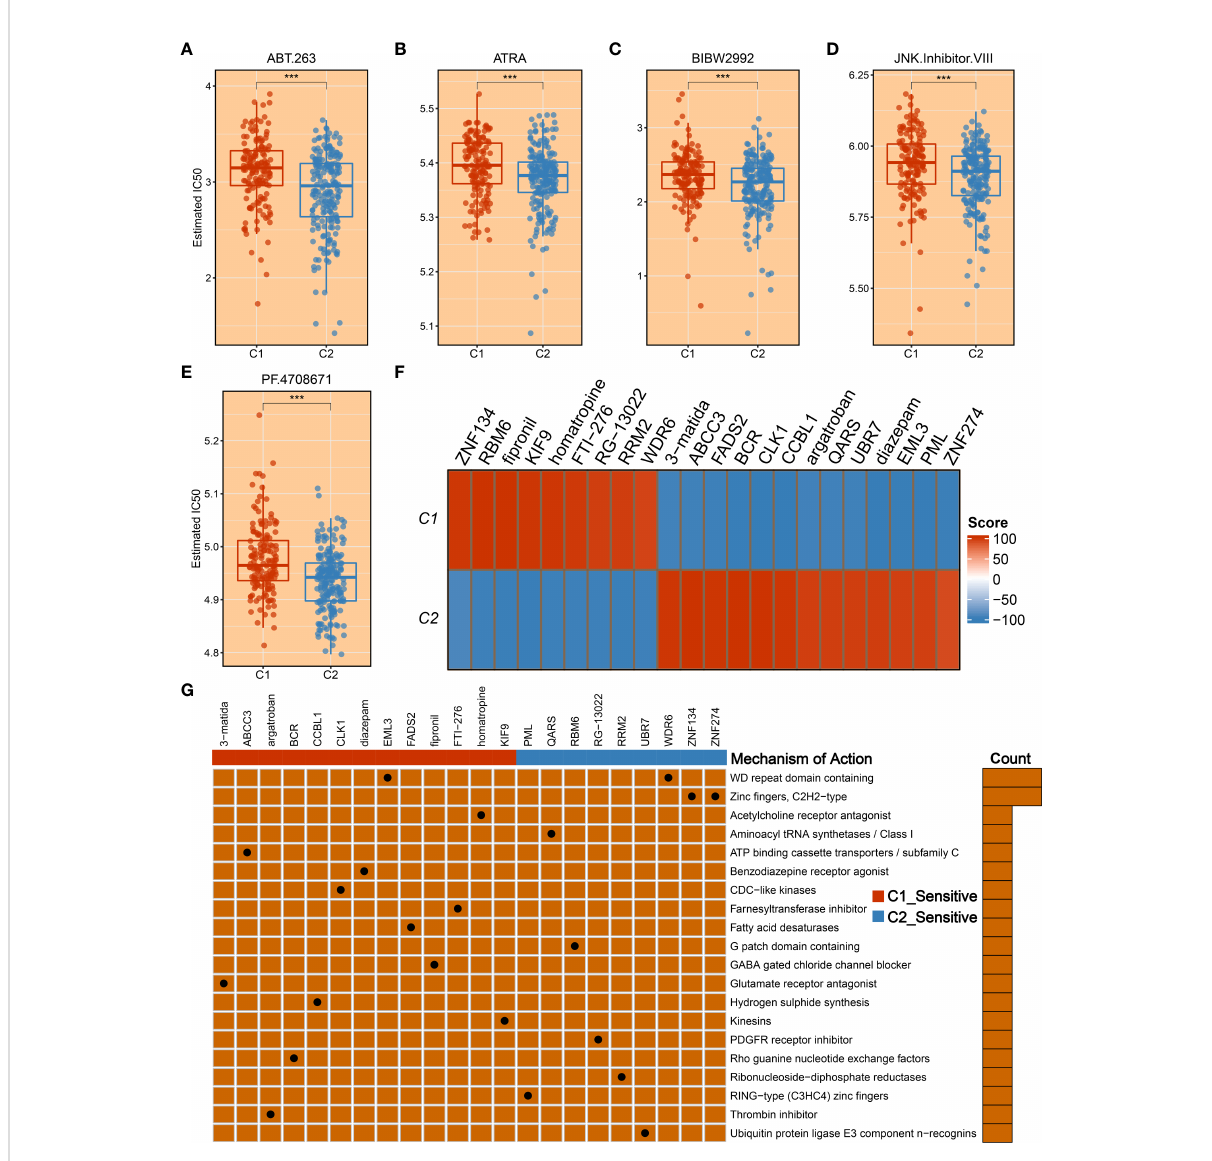
FIGURE 11 The development of promising therapeutic agents and description of targeted molecules and corresponding pathways. (A – E) The promising therapeutic agents for patients in C2, including ABT.263 (A) , ATRA (B) , BIBW2992 (C) , JNK.Inhibitor.VIII (D) , and PF.4708671 (E) . (F) Heatmap of enrichment score generated from potential therapeutic compounds. (G) The description of the mode of action (MoA) of compounds targeting corresponding molecular pathways. ***p <